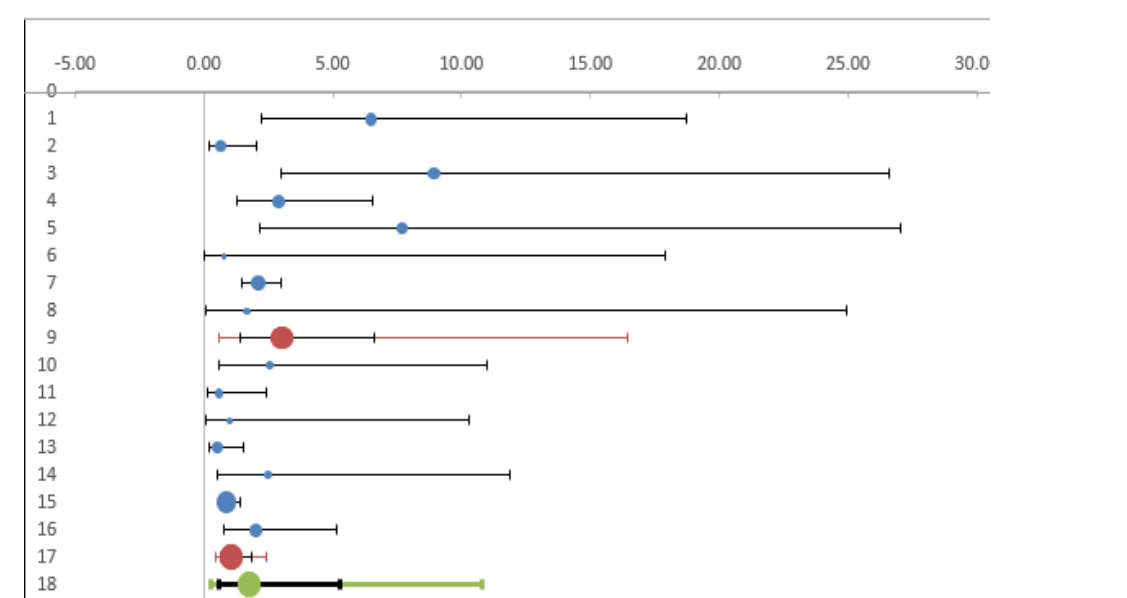
Figure 5. Forest plot. Comparison of studies published before and after 2011.